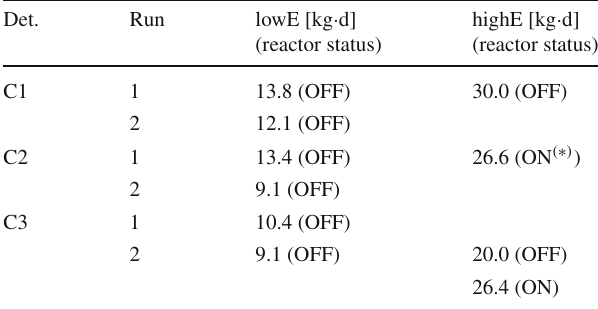
Table 1 Data sets with μ -veto applied used for the construction of